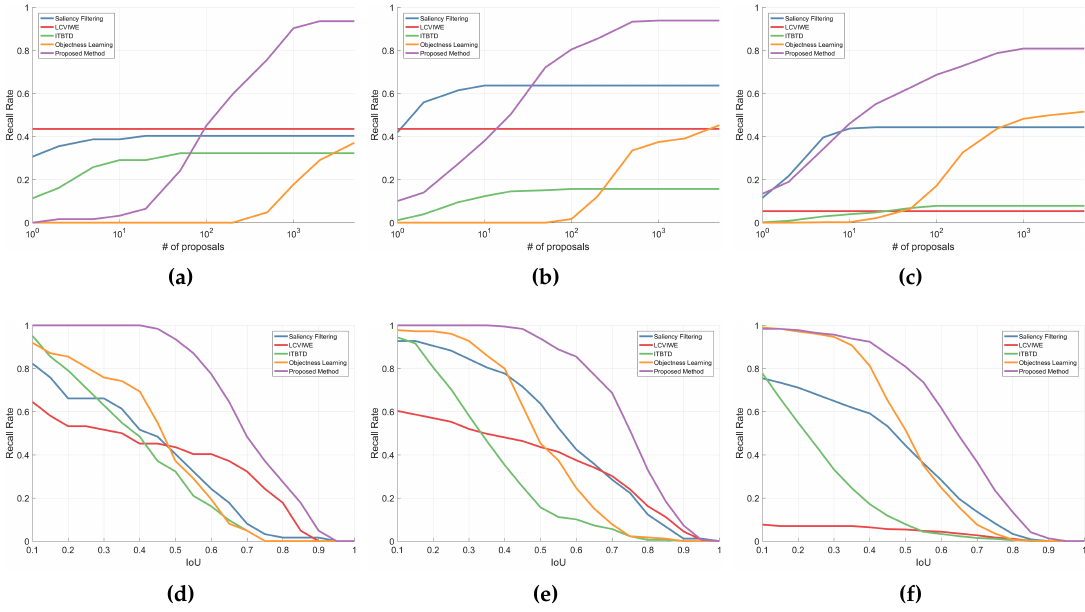
Figure 12. The recall using our method and the state-of-the-art methods on multi-scale datasets. ( a – c ) the curves measuring the recall versus numbers of ship proposals on test datasets that contain large, middle and small scale ships; ( d – f ) the curves measuring the recall versus IoU on test datasets that contain large, middle and small scale ships.